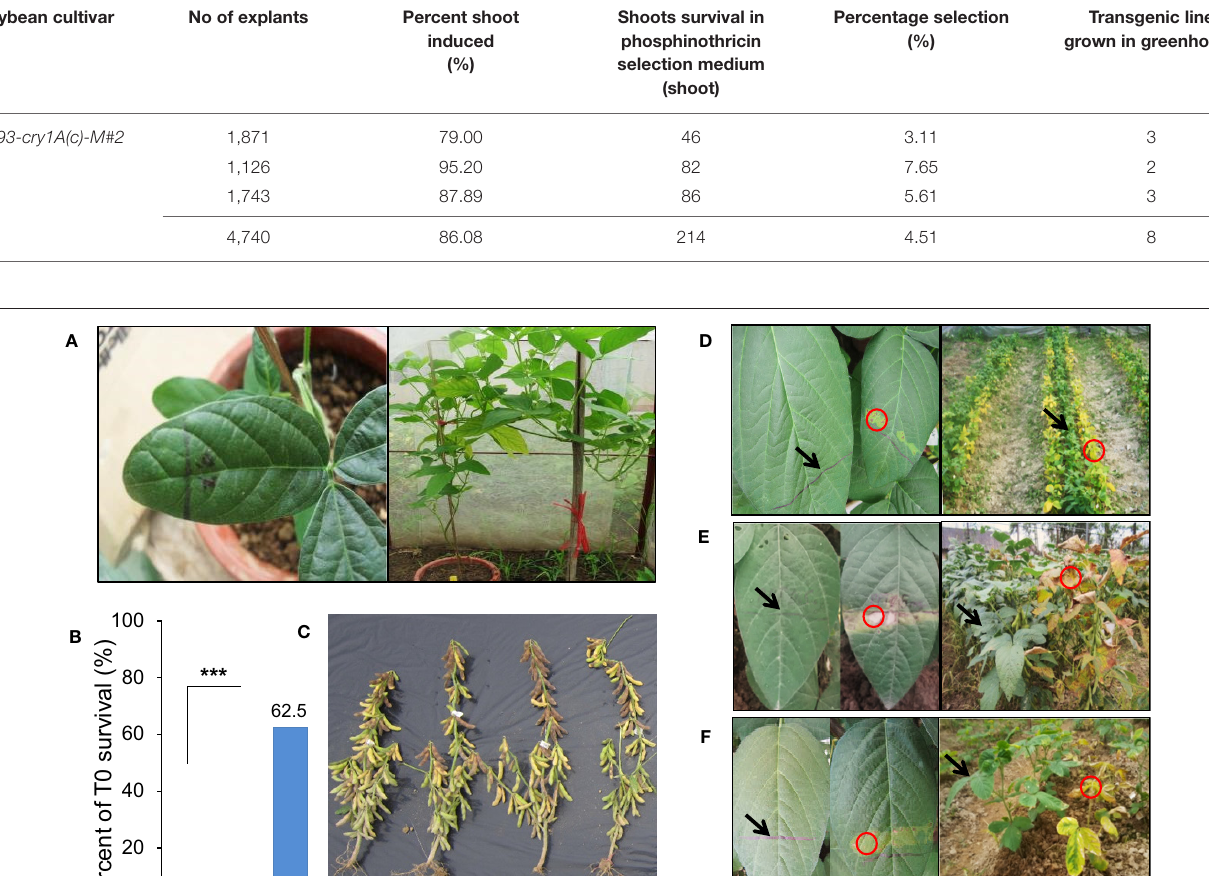
Frontiers in Plant Science |